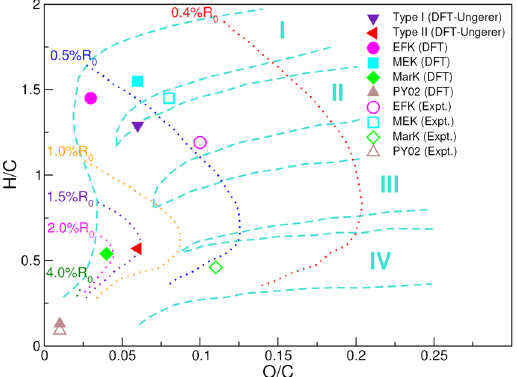
Figure 4. van Krevelen diagram displaying H/C versus O/C ratios for kerogen structures of the sophisticated EFK, MEK, MarK and PY02 models from Bousige et al . (ref. 5) and their simplified variants used in the present DFPT calculations, as well as the type-I and -II structures proposed by Ungerer et al . (ref. 4). Isovalue contour lines of the vitrinite reflectance R 0 , another common maturity indicator, are also represented, along with typical domains (cyan) for kerogen samples with different depositional origins (types I to IV). Maturation increases with decreasing H/C and O/C